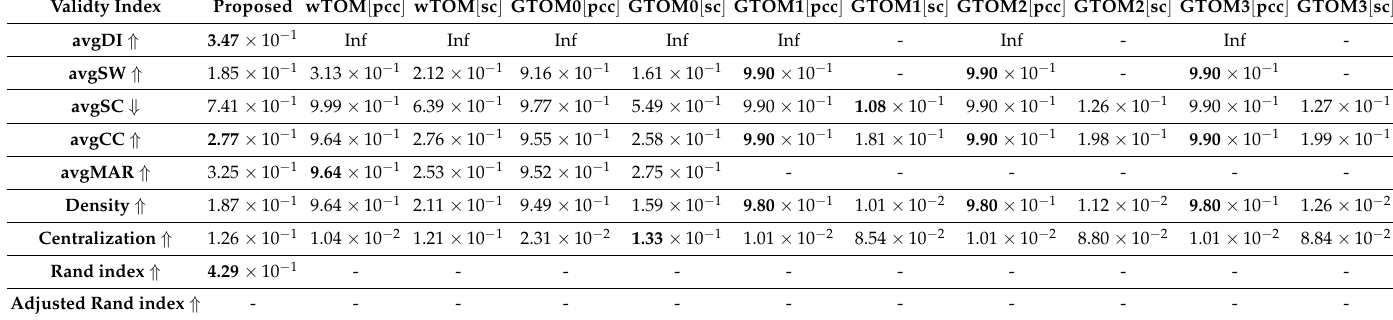
Table 4. Comparison of proposed rule-based gene-module detection method and other existing geneset-based gene-module detection methods for the cervical carcinogenesis